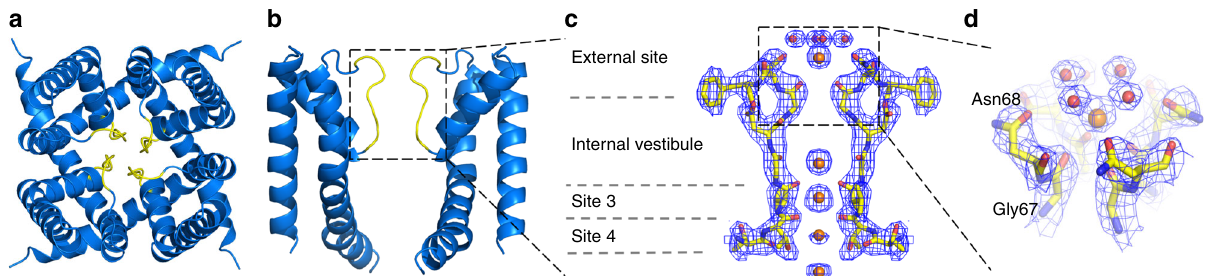
Fig. 2 Structural model of the NaK channel determined by MicroED. The top ( a ) and side ( b ) views, respectively, of the overall structure of NaK in a cartoon representation (blue) and the selectivity fi lter in yellow. (The front and back subunits in b are removed for clarity). c The selectivity fi lter region (yellow) in b is shown in the stick representation for closer examination, overlaid with 2 F o – F c MicroED density map contoured at 1.5 σ for molB. Densities inside the selectivity fi lter include Na + ions and waters shown as orange and red spheres, respectively. d The external site bound with a partially hydrated Na + ion in c is magni fi ed and shown in a three-dimensional model with the density